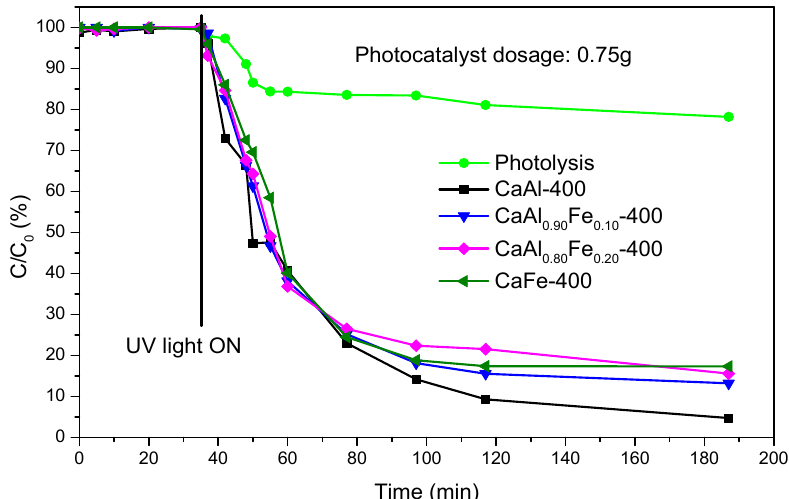
Figure 10. Ibuprofen degradation using samples calcined at 400 °C (photolysis is included for comparison).